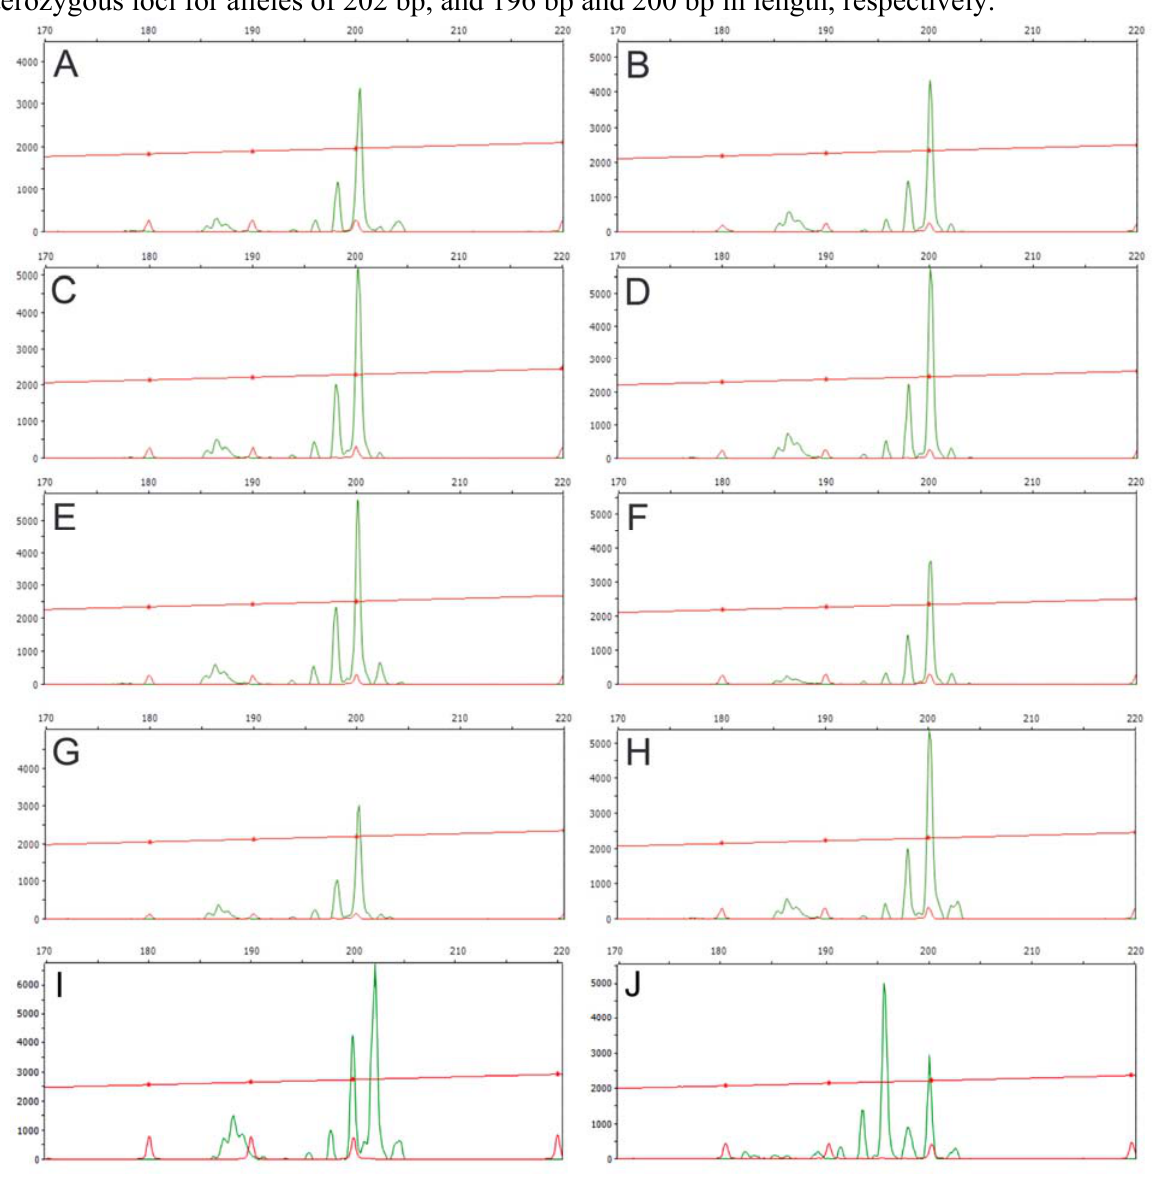
Appendix 1. DNA fragment profiles showing microsatellite loci assayed with primer JcSSR7